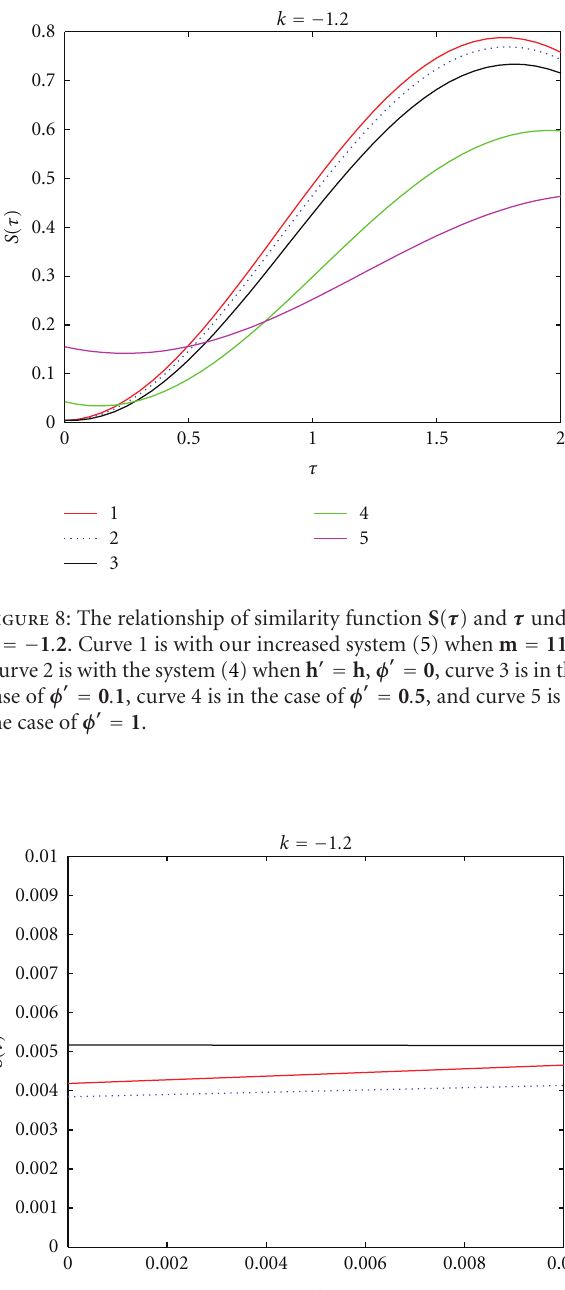
Figure 11: The relationship of similarity function S ( τ ) and τ under k = − 10 (enlarged part of Figure